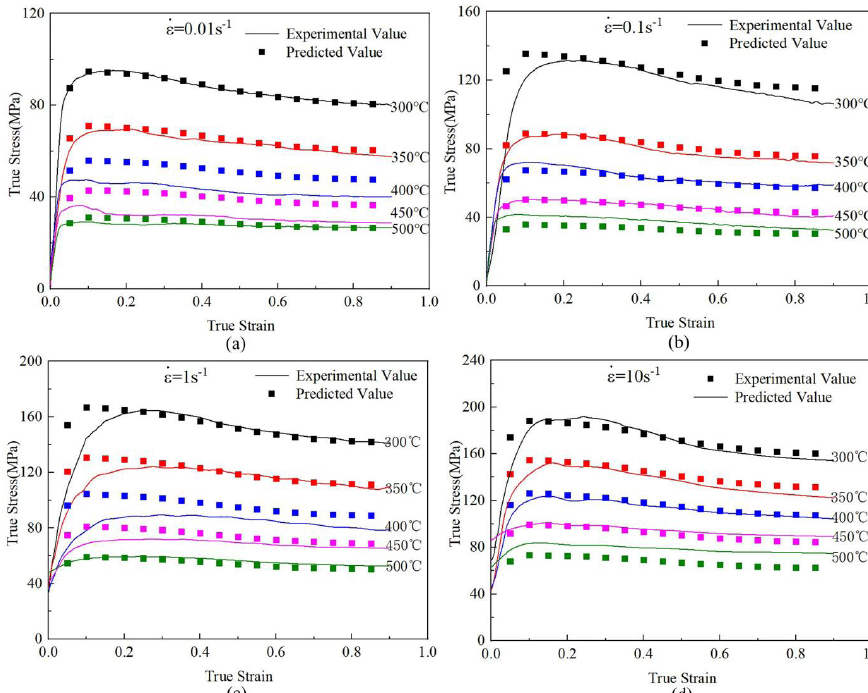
Figure 8. The comparison between predictions of modified Johnson-Cook model and experimental results.